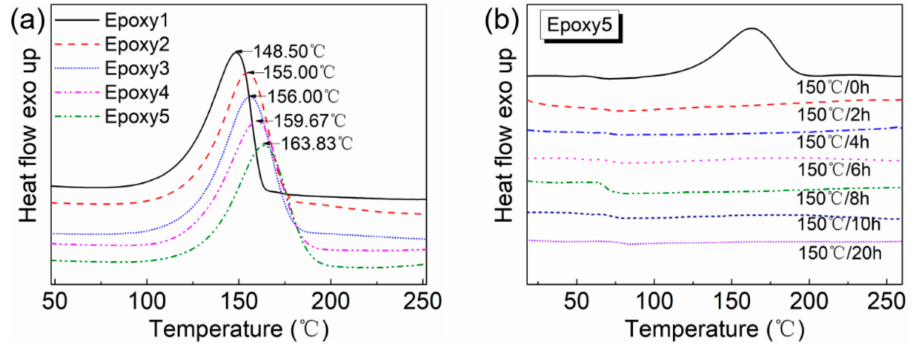
Figure 3. ( a ) Differential Scanning Calorimeter (DSC) curves of five uncured epoxy resin systems with different GA contents at the heating rate of 10 ◦ C/min under a nitrogen atmosphere; ( b ) DSC curves of Epoxy5 after pre-cured at 100 ◦ C for 2 h and post-cured at 150 ◦ C for different hours at the heating rate of 10 ◦ C /min under a nitrogen atmosphere.